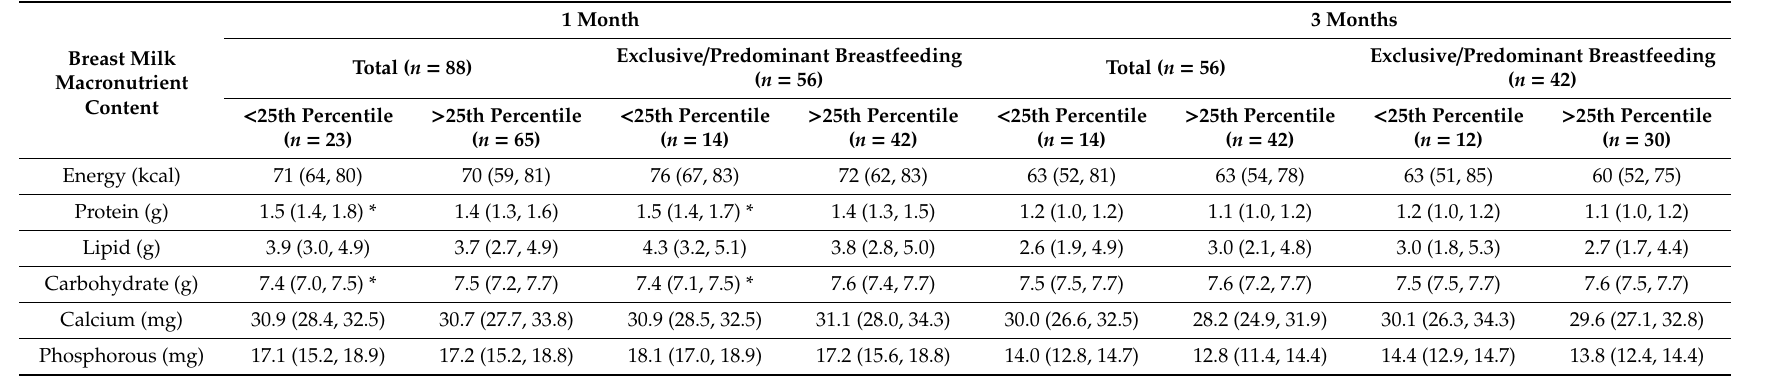
Table 5. Breast milk macronutrient content according to infant weight above and below the 25th percentile at 1 and 3 months after birth.